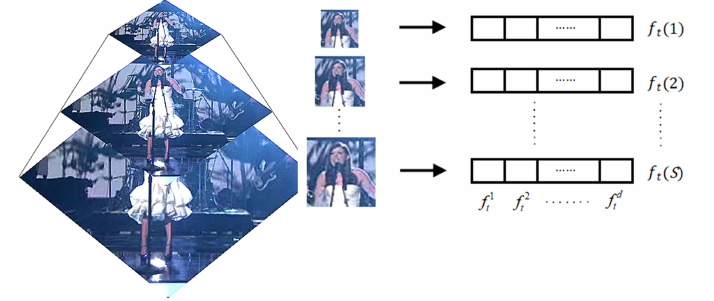
Figure 2. The Visualization of Scale Space Filter